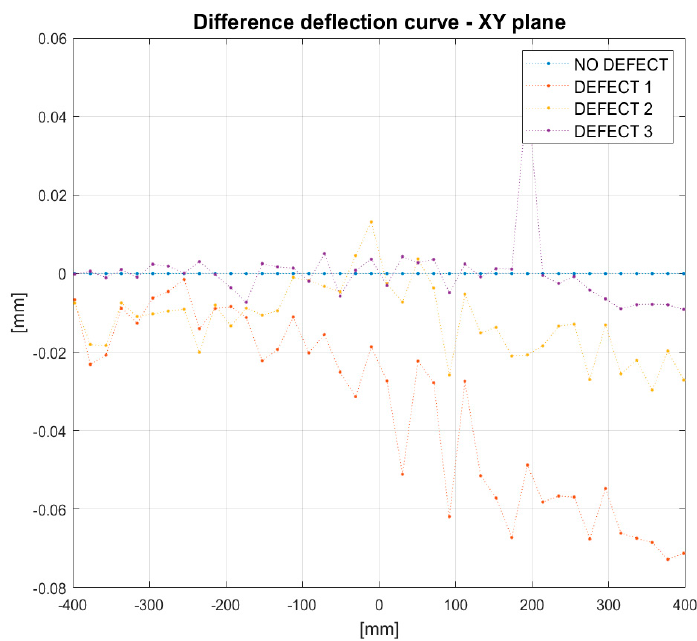
Figure 14. Difference in deflection of the beam under load for different damage conditions.